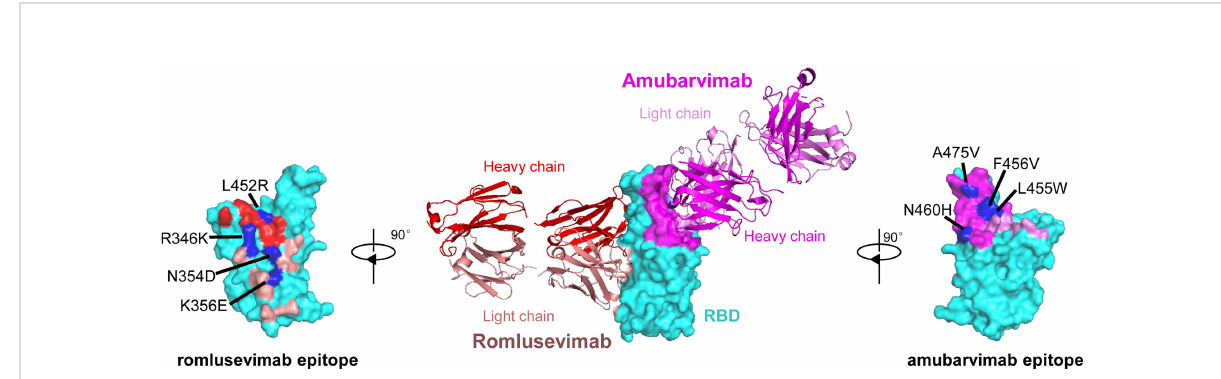
FIGURE 2 Co-crystal structure of SARS-CoV-2-RBD/amubarvimab/romlusevimab. Amubarvimab and romlusevimab simultaneously bind to distinct, nonoverlapping epitopes on the RBD of spike protein. A side-view depiction shows cartoon representations of amubarvimab (magenta) and romlusevimab (red) together with RBD (cyan) in surface representation based on co-crystal structure of amubarvimab and romlusevimab Fabs with RBD. Romlusevimab epitope (red) and amubarvimab epitope (magenta) with mutation sites of impact on neutralization IC 50 over approximately 100-fold are marked in